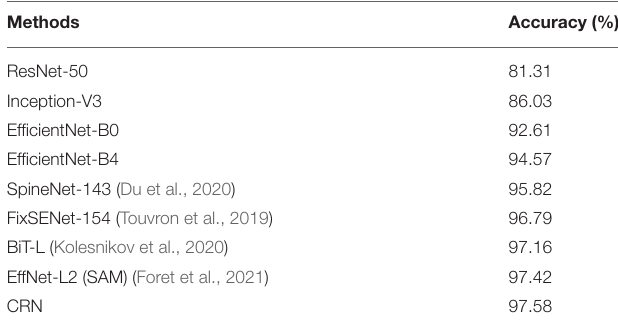
Algorithm 1: CRN algorithm. TABLE 2 | Comparison with benchmarks and state-of-the-art methods on the test